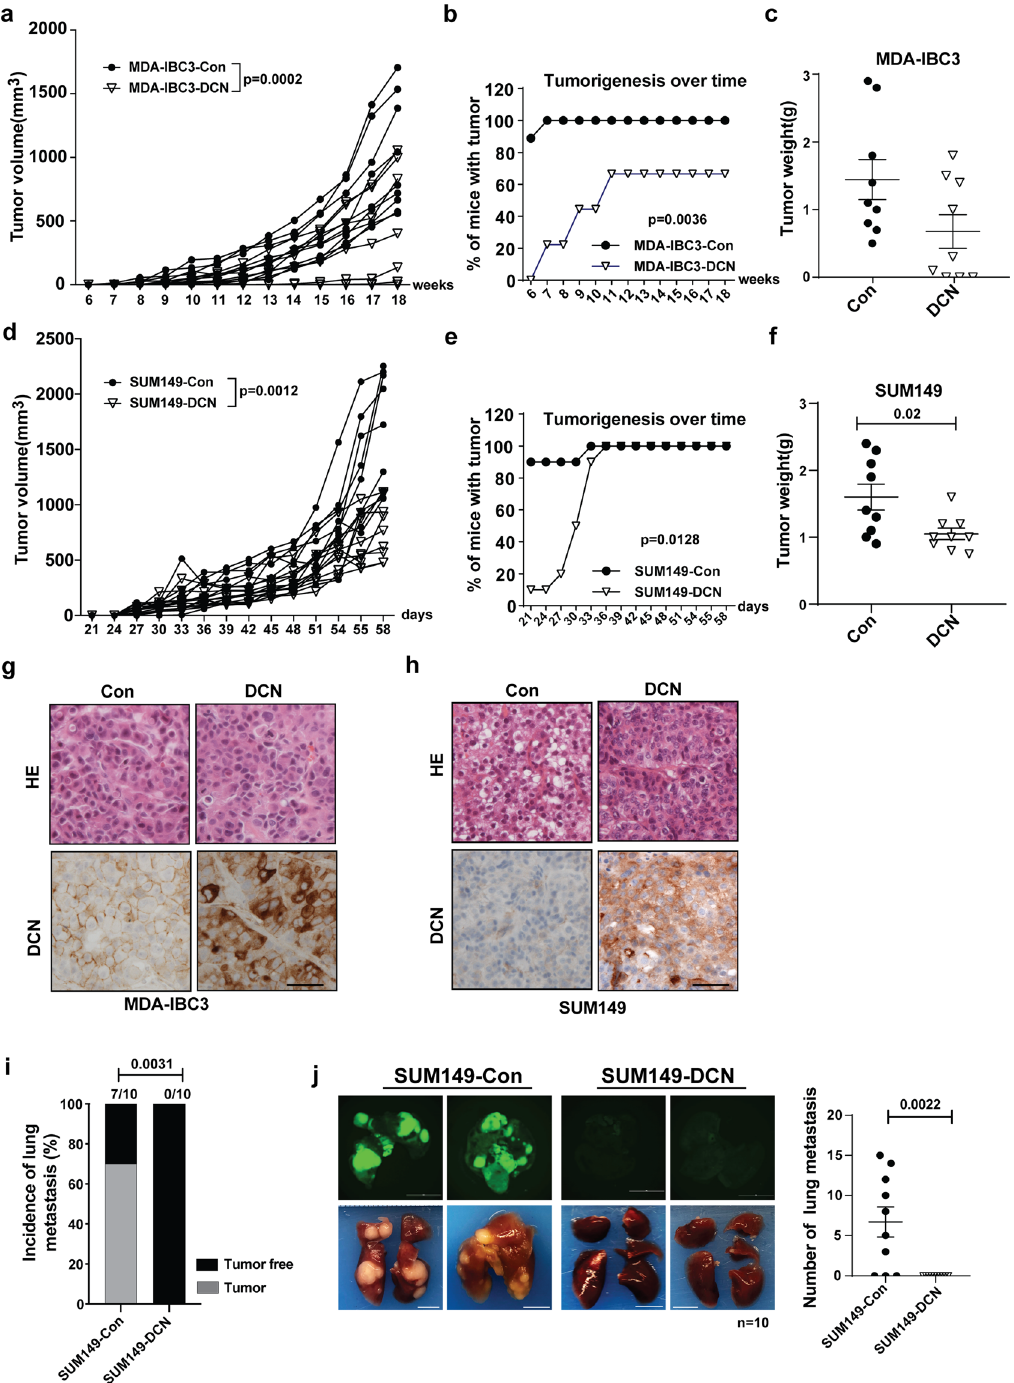
with DCN-overexpressing SUM149 or MDA-IBC3 cells had sig- ni fi cantly reduced tumor size, tumor growth rates, and tumor weights as compared with control mice (Fig. 2a – f). Immunohis- tochemical staining con fi rmed overexpression of DCN in tumors generated from DCN-overexpressing cells (Fig. 2g, h). We also injected control or DCN-overexpressing SUM149 cells into the tail veins of SCID/Beige mice to evaluate lung metastatic colo- nization by incidence (number of mice with any lung metastases), average burden among mice with lung metastases, and average number of lung metastases per mouse. DCN completely inhibited the incidence of lung metastasis as compared with the control group (0% DCN vs. 70% control, p = 0.0031, Fisher exact test,